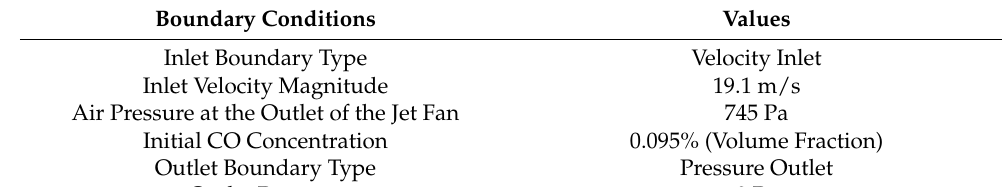
Table 8. Boundary conditions for Tset 2.